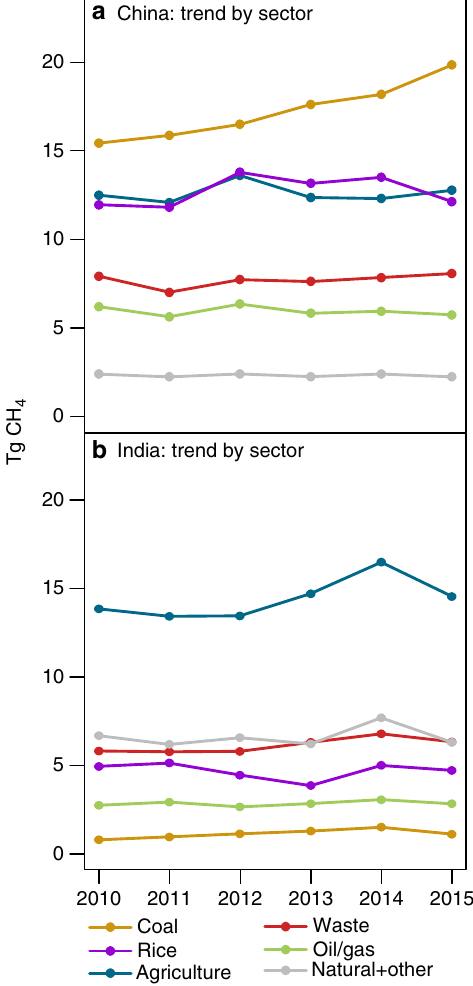
Fig. 5 Emissions trends by sector. a , b show the estimated emissions trend by sector for China and India, respectively. The coal sector appears to be driving the trend in China. No clear trends are obvious for India. Note that all trends in this fi gure are driven by the GOSAT observations, not by the EDGAR anthropogenic emissions inventory used in the inverse model; the inventory estimate is constant with time. The EDGAR inventory does not include uncertainty estimates for the sector-speci fi c breakdown of emissions, and uncertainty estimates are therefore not included here. Figure 3 and Supplementary Fig. 2 present uncertainties for the